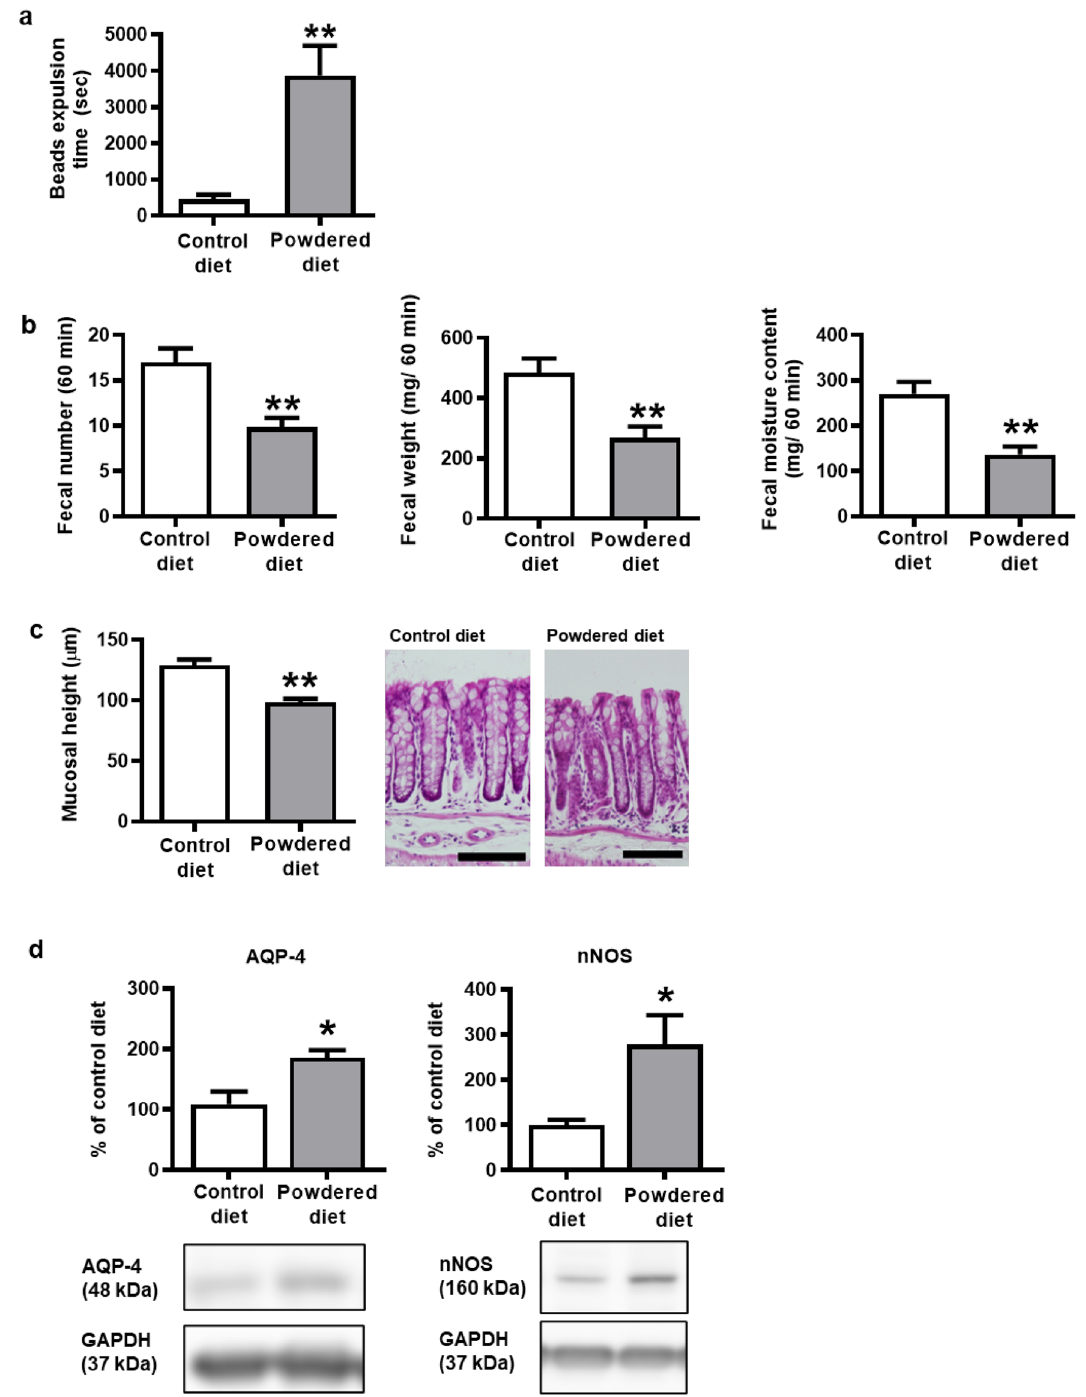
Figure 1. Effects of long-term powdered diet feeding on the colonic motility, colonic mucosal length, and expressions of aquaporin-4 (AQP-4) and neural nitric oxide synthase (nNOS) in the colons of mice. ( a ) Bead expulsion test (p = 0.0024, n = 4 or 5 per group). ( b ) Fecal pellet output, total fecal weight, and fecal water content (p = 0.0011, 0.0019, and 0.0005, respectively, n = 10 per group). ( c ) The lengths of the colonic mucosa (p < 0.0001, n = 5 or 6 per group). ( d ) Western blotting analysis of aquaporin 4 and nNOS (p = 0.0141 and 0.0281, respectively, n = 3–8 per group). Full length blots are presented in Supplementary Fig. S4. The data are given as the mean ± SEM for a group. Student’s t -test was used to determine statistical significance. *p < 0.05, **p < 0.01; vs. control diet-fed